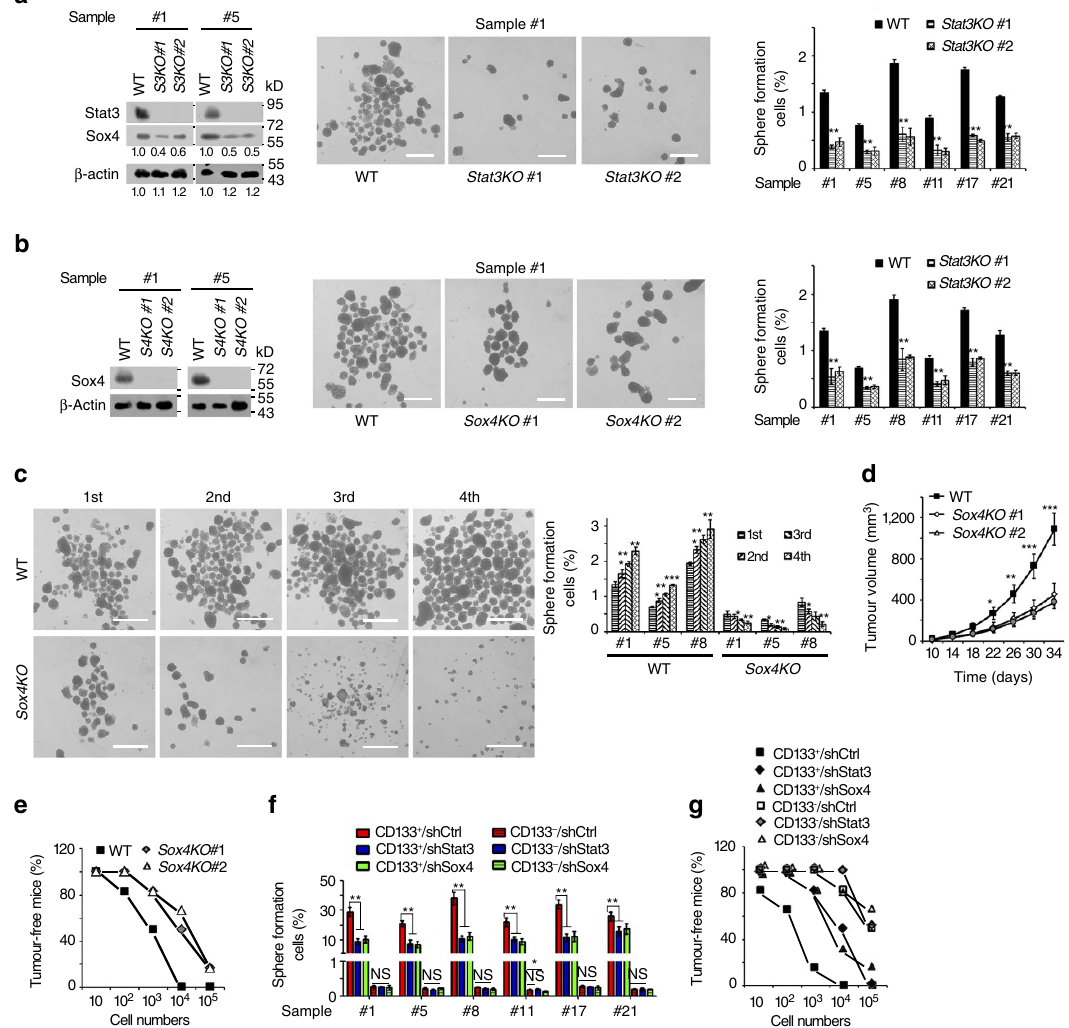
Figure 6 | Stat3/Sox4 is required for liver TIC self-renewal. ( a ) Stat3 is required for liver TIC self-renewal. Impaired Sox4 expression (left panels) and sphere formation capacities (middle and right panels) were found in Stat3 -deficient cells. ( b ) Sox4 -deficient cells were established and sphere formation assays were performed, and impaired sphere formation was observed. ( c ) Sox4 is essential in liver TIC self-renewal. Serial sphere formation assays were performed using Sox4 -deficient or control cells. For each sphere formation assay, 5,000 cells were used. Representative images were shown in the left panel and calculated TIC ratios were shown in the right panel. ( d ) Sox4 drives liver cancer propagation. 1 (cid:2) 10 6 Sox4 -deleted primary HCC cells were subcutaneously injected into BALB/c nude mice, and tumour volume was measured at the indicated time points. ( e ) A total 10, 1 (cid:2) 10 2 , 1 (cid:2) 10 3 , 1 (cid:2) 10 4 and 1 (cid:2) 10 5 Sox4 -deficient primary HCC cells were subcutaneously injected into BALB/c nude mice, and tumour formation was examined 3 months later. ( f , g ) Sphere formation ( f ) and tumour initiation ( g ) assays of Stat3- or Sox4-silenced liver TICs. CD133 þ liver TICs were enriched from primary HCC cells using flow cytometer, followed by infection with Stat3- or Sox4-silenced pSiCoR lentivirus. For f , 5,000 cells were incubated in sphere formation medium for 2 weeks. For g , 10, 1 (cid:2) 10 2 , 1 (cid:2) 10 3 , 1 (cid:2) 10 4 and 1 (cid:2) 10 5 cells were subcutaneously injected into BALB/c nude mice for tumour-initiation assay. Scale bars, 500 m m ( a , b and c) . Data were shown as means ± s.d. Two-tailed Student’s t -test was used for statistical analysis. * P o 0.05; ** P o 0.01; *** P o 0.001. P o 0.05 was considered significant. Data are representative of three independent experiments. For a and b , the original images are shown in Supplementary Fig. 6. NS, not